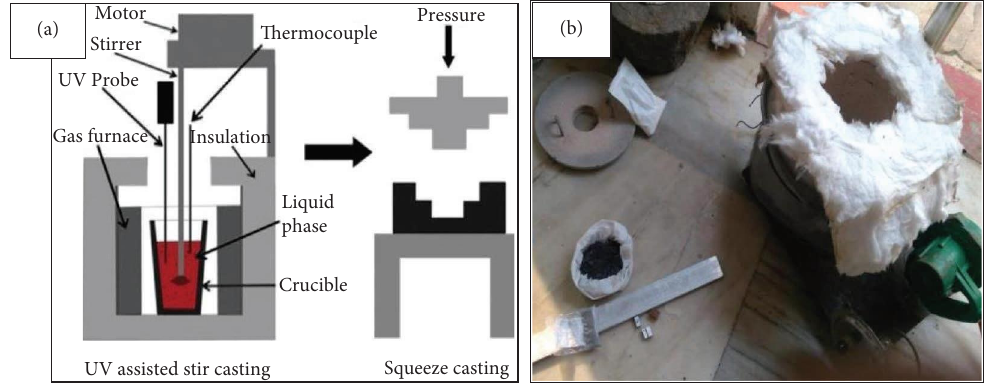
Figure 1: (a) Schematic setup and (b) mufe